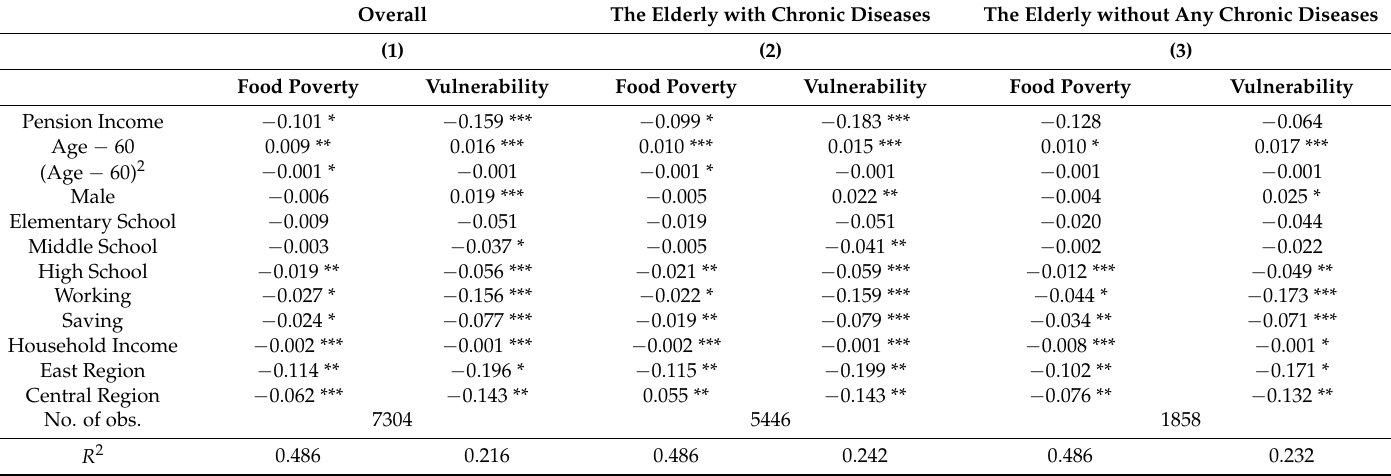
Table A2. Effects of pension income on food poverty and vulnerability of the elderly aged between 48 and 72. Overall The Elderly with Chronic Diseases The Elderly without Any Chronic Diseases (1) Food Poverty Vulnerability Food Poverty Vulnerability Food Poverty